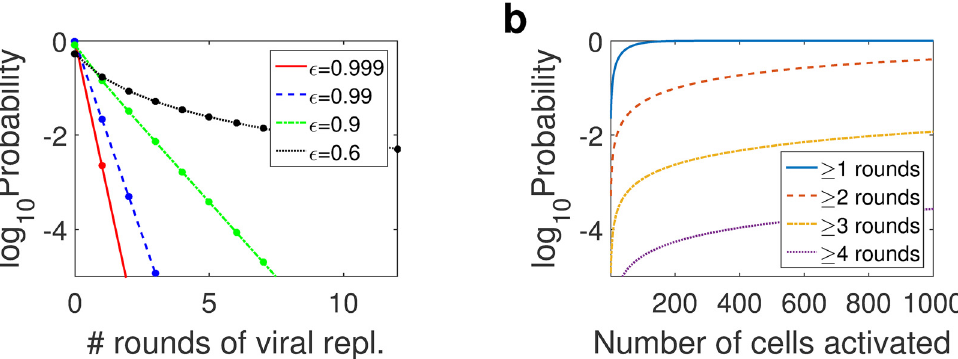
Fig 4. Probability distribution of number of viral replications following activation of a latently infected cell. (a) Probability of the number of rounds of viral replication following the activation of a single latently infected cell, assuming drug efficacy ε = 0.999, 0.99, and 0.9, which are associated with reproductive ratios R = 0.0023, 0.023, and 0.23, and initial viral loads V 0 = 3, 3.1, and 4 copies/mL, respectively. (b) The probability of the maximum number of rounds of viral replication achieved as a function of the number of latent cell activations, using ε = 0.99, which is associated with R = 0.023 and initial viral load V 0 = 3.1 copies/mL. Note that these are discrete distribution functions, with the dots in (a) indicating probability of cells achieving k generations; the lines are included for clarity and have no